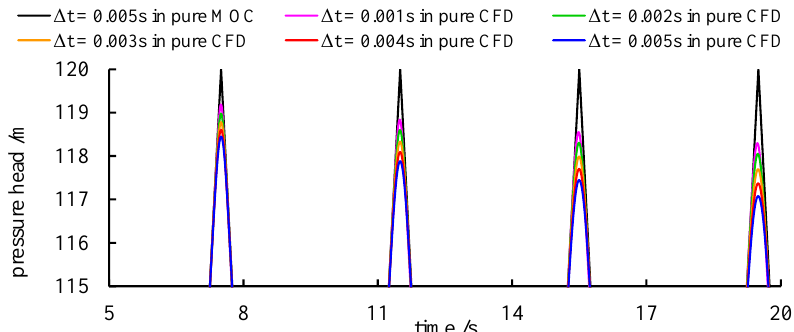
Figure 5. Peak value of the pressure head under various time step sizes.